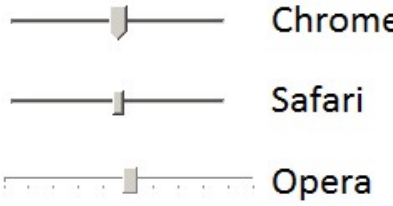
Fig. 8. Display of a “range” element in different browsers.